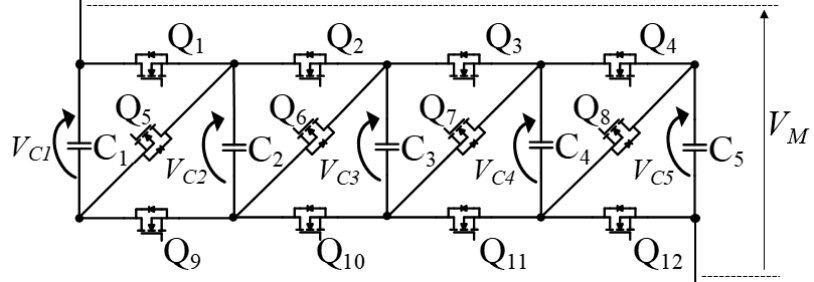
Figure 7. Proposed series-parallel reconfiguration circuit for five cells.